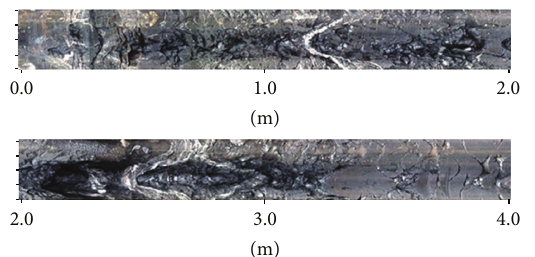
Figure 10: Borehole camera information of columnar joints.